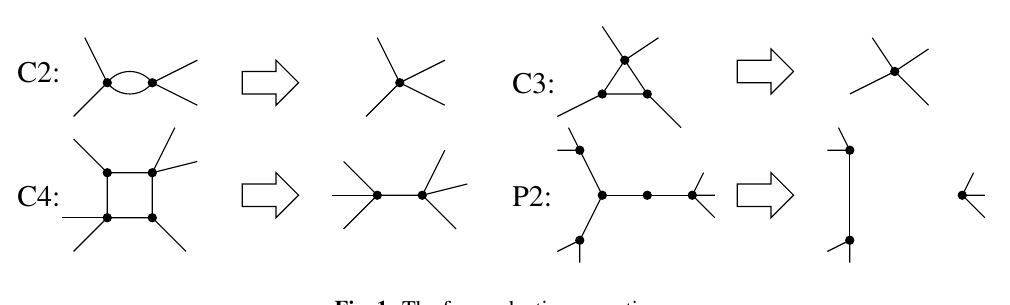
Fig. 1: The four reduction